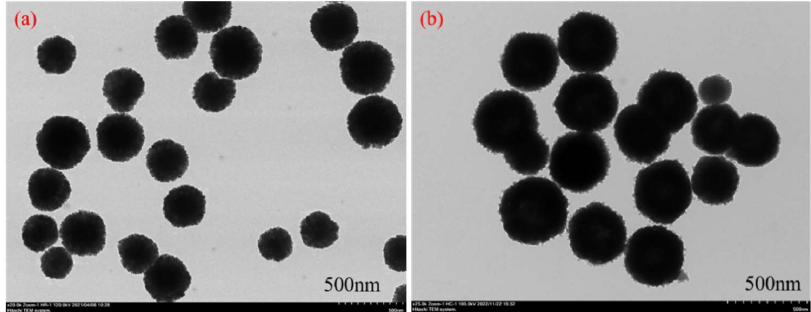
Figure 2. Transmission electron micrographs of Fe 3 O 4 ( a ) and Fe 3 O 4 @PS ( b ).